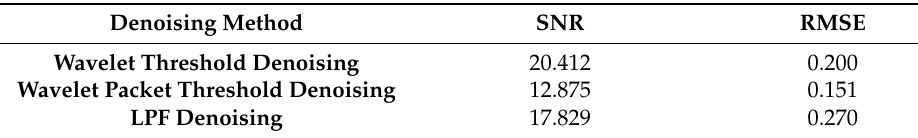
Figure 9. ALLAN deviation map after denoising the airborne sensor signal. Table 2. Denoising results of the two methods.